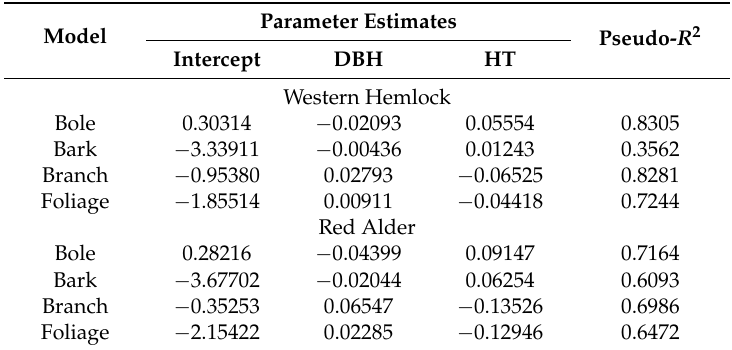
Table 5. Parameter estimates and pseudo- R 2 values for the component biomass models for Western hemlock and red alder trees using beta regression.